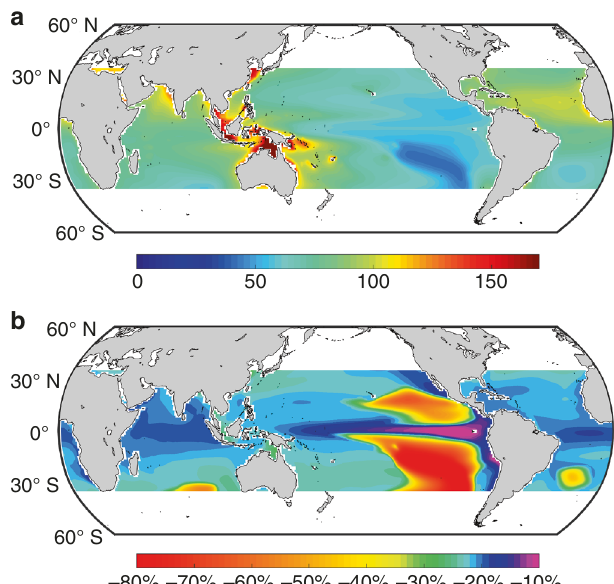
Fig. 5 The projected Trichodesmium N 2 fi xation potential. a Results [mmol N (mol C) − 1 d − 1 ] in 1990s and b relative change from 1990s to